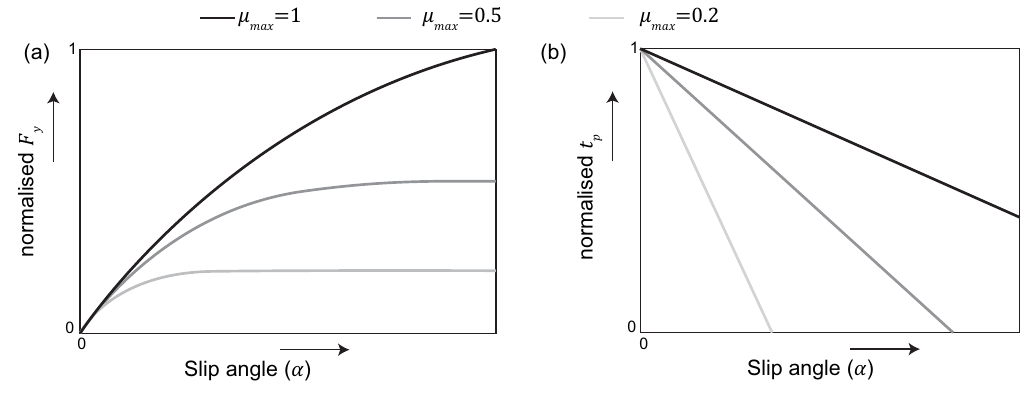
Figure 17. ( a ) Normalised tyre lateral forces; ( b ) normalised tyre pneumatic trail for different road friction potential coefficients. Figure adapted by the authors from Hsu et al.